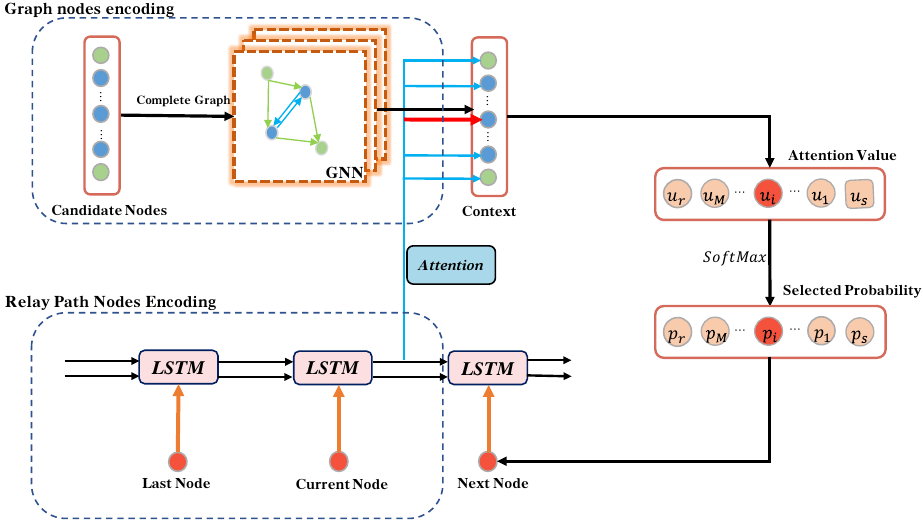
Figure 3. The Structure of